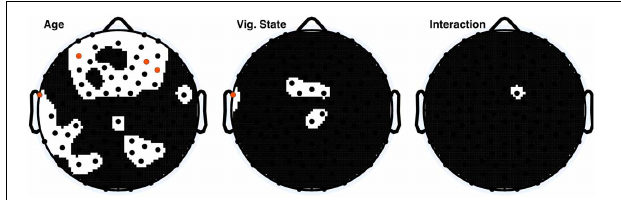
FIGURE 4 | ANOVA p -value distributions from 8Hz high pass filtered data; electrodes with factor effect p -values less than 0 . 05 are those displayed in black on the white background. Electrodes with significant p -values following Holm–Bonferroni correction are depicted in orange. The nasion electrode (not shown) was not significant at any level for any effect.